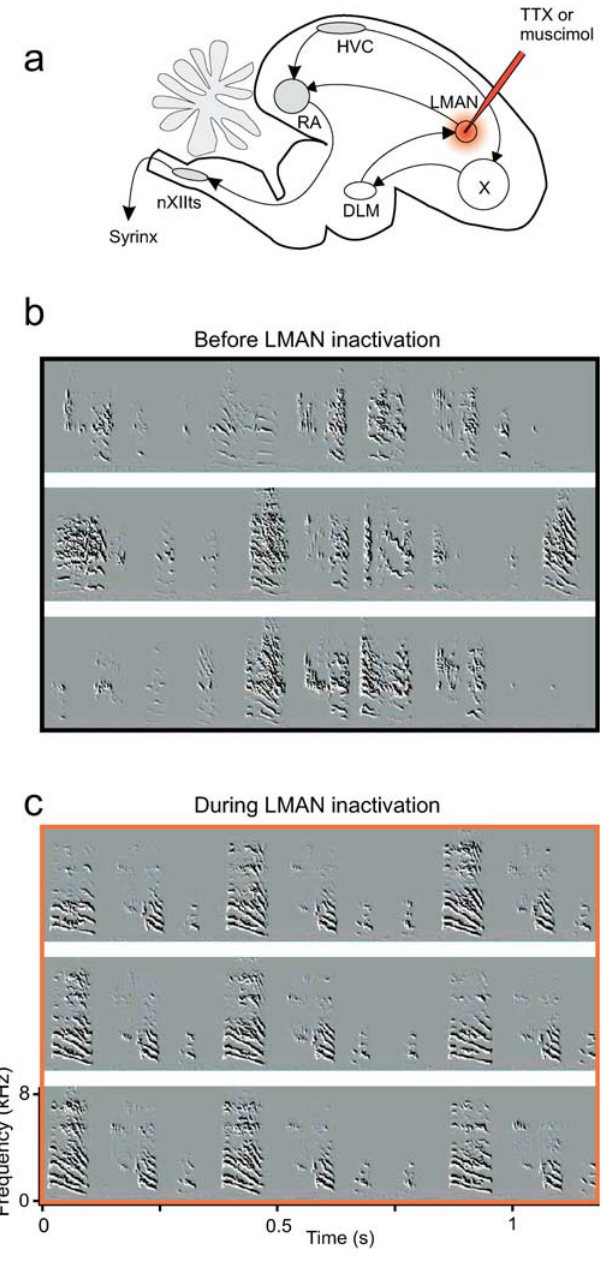
Figure 1. Inactivation of LMAN Significantly Reduces Vocal Experimen- tation, Making the Otherwise Variable Song of the Juvenile Zebra Finch Highly Stereotyped (A) Two major pathways in the vocal control system of the songbird. The motor pathway (gray) includes motor cortex analogs HVC and RA, while the AFP (white), a basal ganglia thalamo-cortical circuit, consists of Area X, the dorsolateral anterior thalamic nucleus (DLM), and LMAN, which, in turn, projects to RA. To inactivate the output of the AFP, injections of TTX and muscimol (red bolus) were made into LMAN. (B) Examples of a juvenile zebra finch song (57 dph) showing large variability in the sequence and acoustic structure of song syllables. (C) Inactivating LMAN with TTX produces an immediate reduction of sequence and acoustic variability, revealing a highly stereotyped song produced by the motor pathway. The song snippets shown in (B) and (C) are from consecutive song bouts, immediately before and 1 h after drug injection. Songs are displayed as spectral derivatives calculated as described [36].